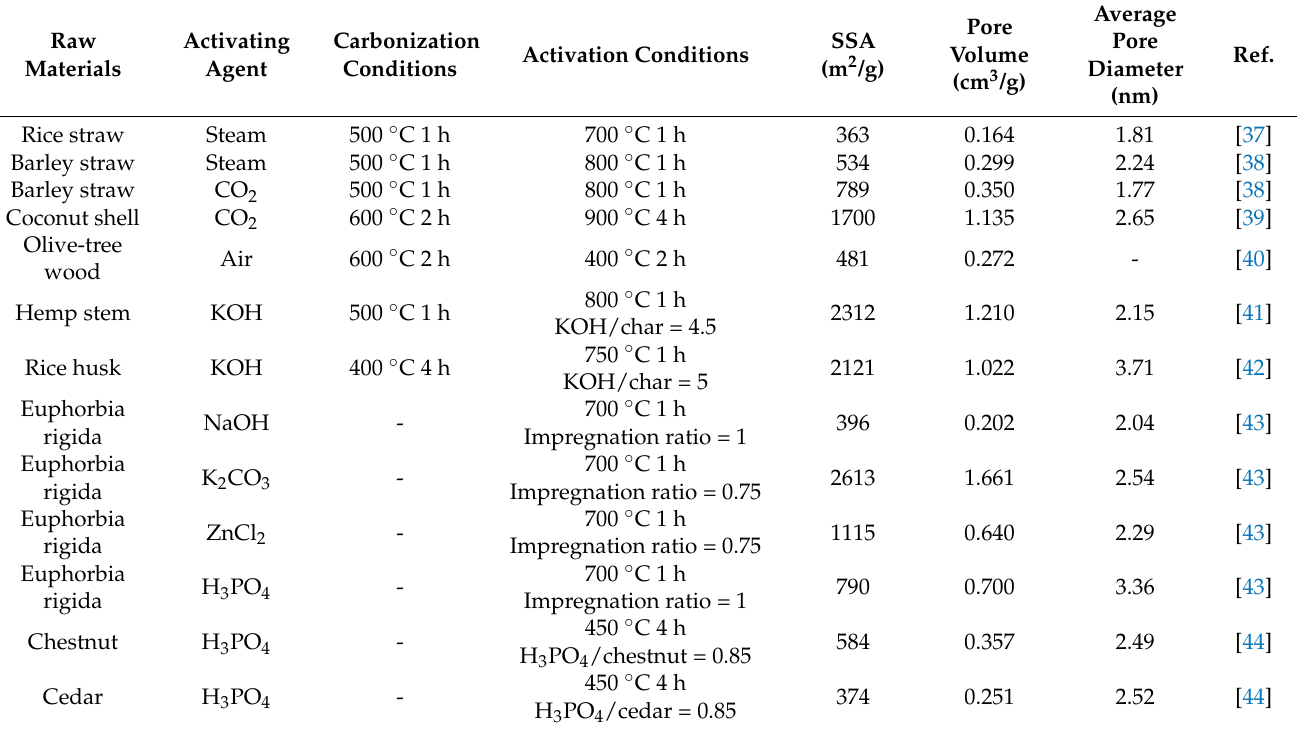
Table 1. Pore structure parameters of ACs prepared from LB by different activation